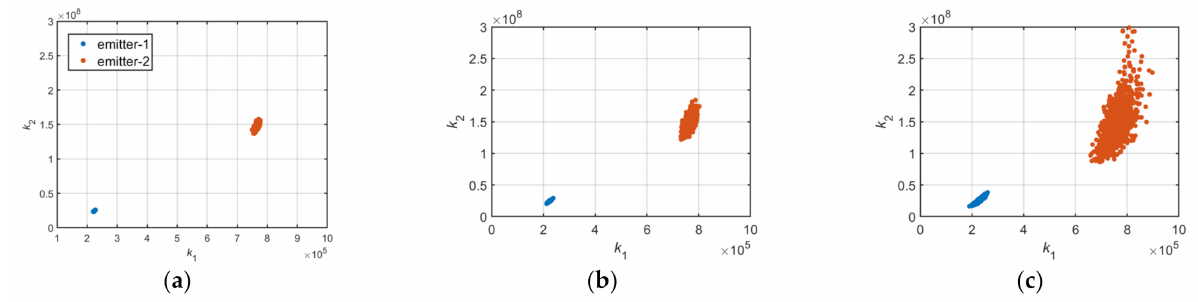
Figure 8. ( a ) k 1 , k 2 of two distinct emitters at 30 dB SNR; ( b ) k 1 , k 2 of two emitters at 20 dB SNR; ( c ) k 1 , k 2 of two emitters at 10 dB SNR.